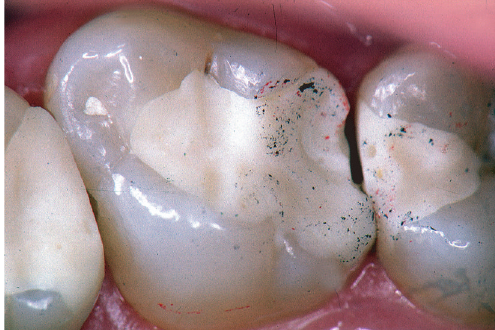
Figure 3: Ketac Molar restoration after 6 months. Chipping occured in the occlusal-proximal contact area.